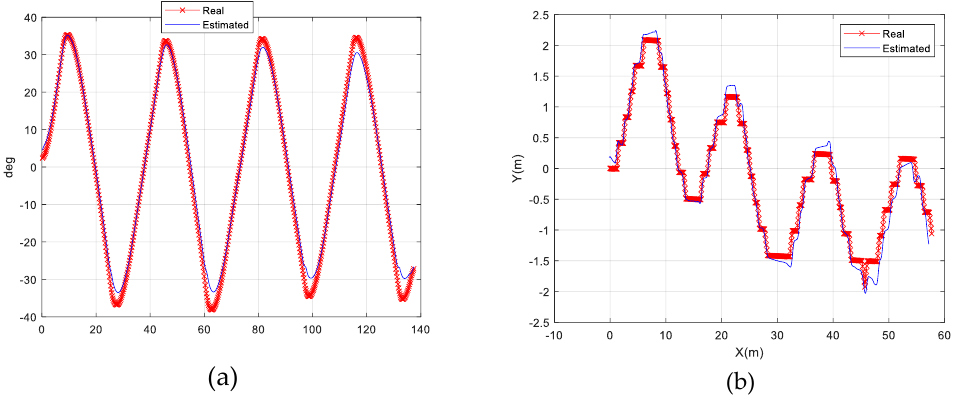
Figure 5. Trial #2 — Zig-Zag 30 – 30. ( a ) Heading angle estimation; ( b ) trajectory prediction.